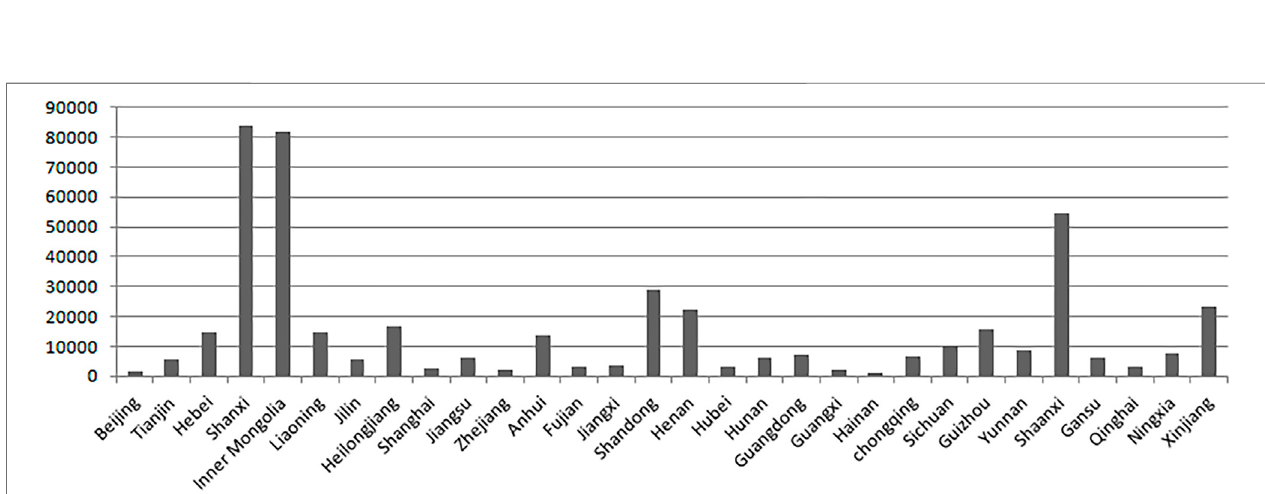
FIGURE 2 | Energy extraction volume in China ’ s provinces (average from 2004 to 2020, standard coal).